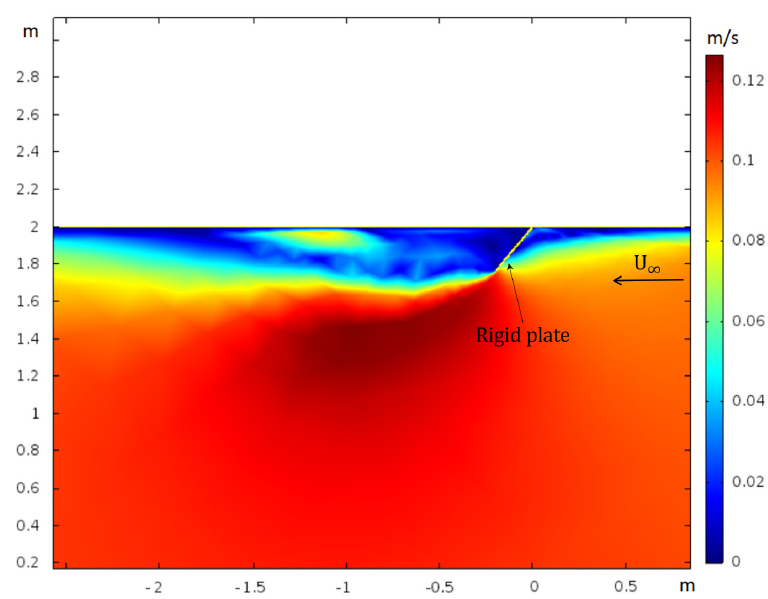
Figure 4. Fluid velocity magnitude for α = 50 ◦ and U ∞ = 0.1 m/s at steady state, obtained via numerical simulations.